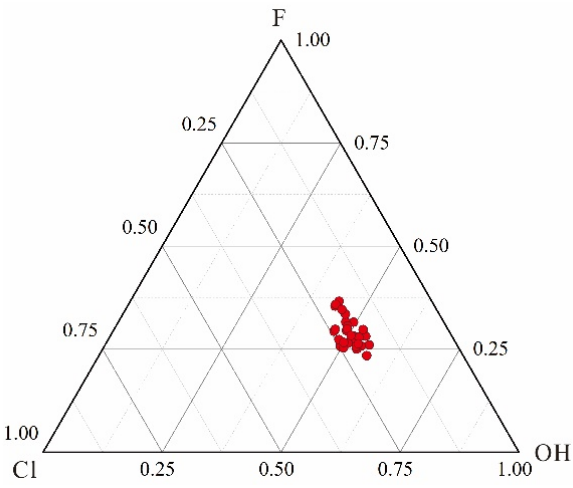
Figure 5. Volatile contents (molar fraction) of apatites from the dacite.